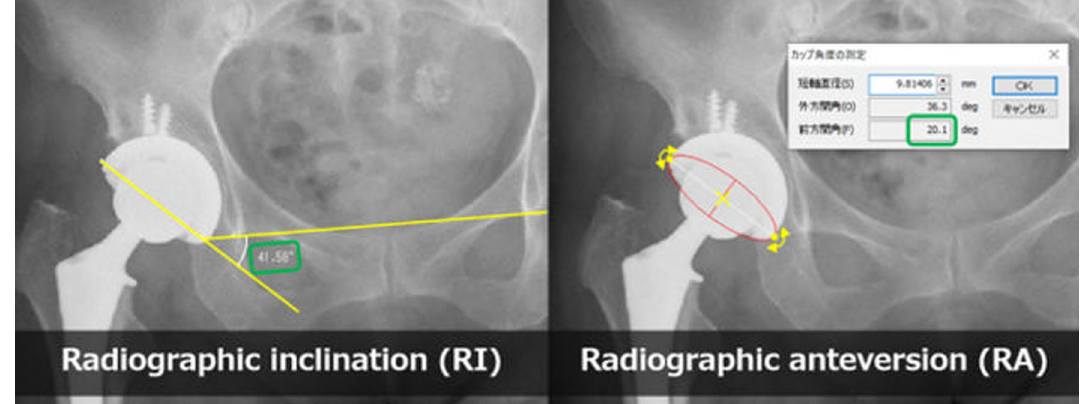
Figure 6. Postoperative radiographic inclination and radiographic anteversion were measured using 2D Template (Kyocera Medical).